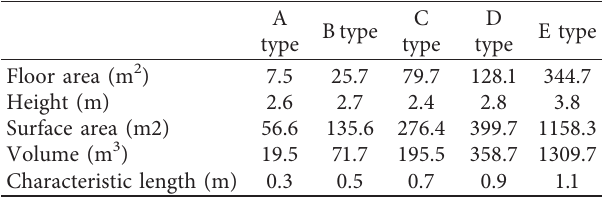
Table 1: Geographical information of target